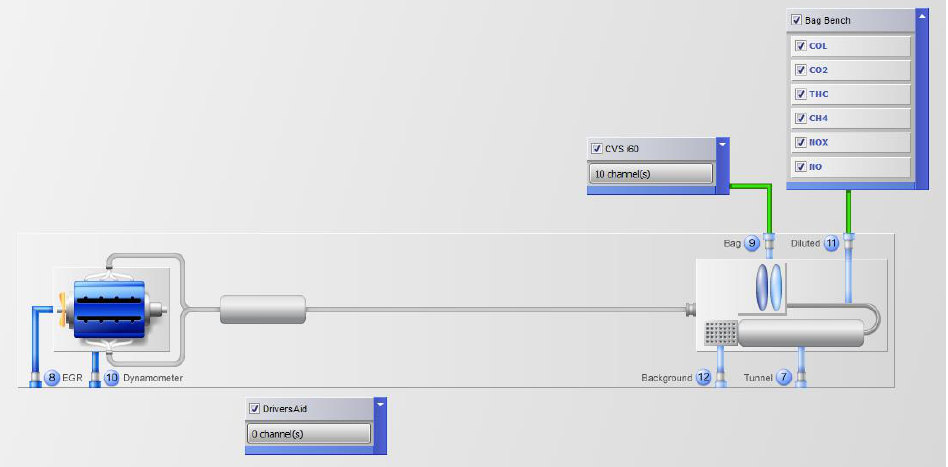
Figure 1. Diagram of the measuring system used in the tests. Table 5. Accuracy of the measuring